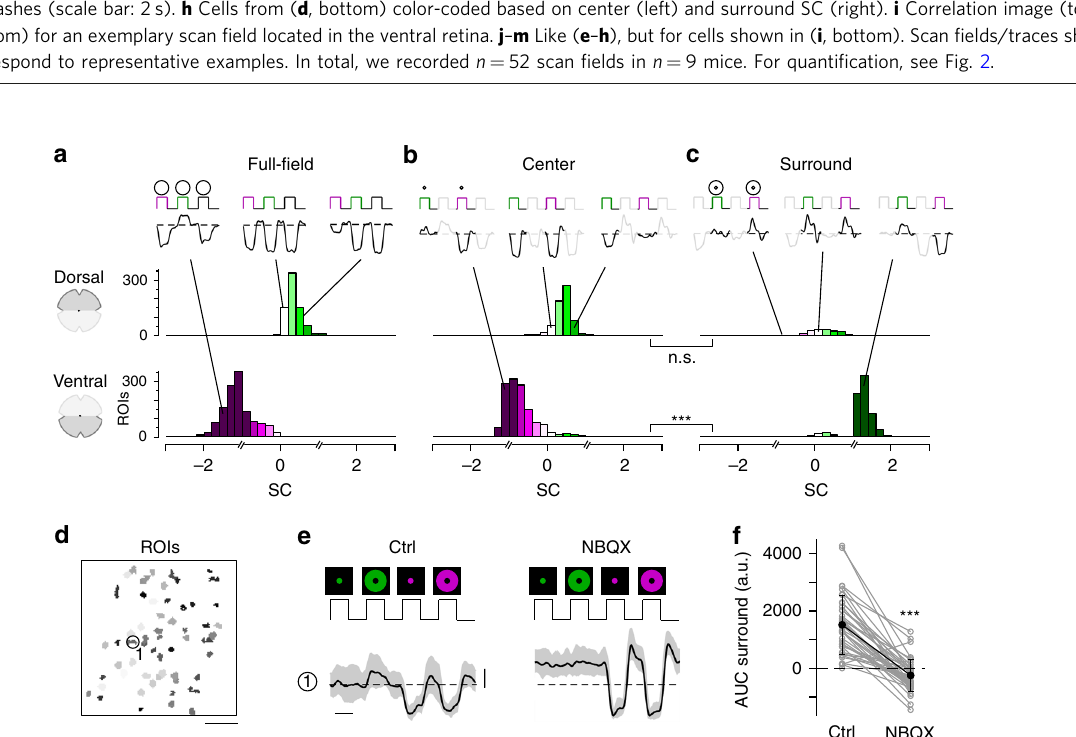
Fig. 2 Differential chromatic processing in ventral and dorsal cones. a – c Histograms of spectral contrast (SC) of dorsal (top) and ventral (bottom) cones in response to full- fi eld ( a , n = 791/1329 dorsal/ventral ROIs), center ( b , n = 671/1337 dorsal/ventral ROIs), and surround ( c , n = 216/841 dorsal/ventral ROIs) fl ashes. Mean glutamate traces of single cones above histograms illustrate the diversity of cone responses to chromatic stimuli. Interestingly, only a fraction of cones showed antagonistic surround responses characterized by an increase in glutamate release (dorsal retina: n = 689/922 cones; ventral retina: n = 1344/2181 cones, n = 52 scan fi elds, n = 9 mice; Supplementary Discussion). Breaks in the x -axis indicate where different equations for estimating SC were used (Methods). n.s. not signi fi cant ( p = 0.053); *** p = 2.2 × 10 − 16 ; linear mixed-effects model for partially paired data (for details, see Methods and Supplementary Methods). d ROI mask of scan fi eld located in ventral retina. Scale bar: 20 µ m. e Glutamate traces of exemplary cone from d in response to UV and green center and surround fl ashes under control and drug condition (50 µ M NBQX). Traces show mean glutamate release with s. d. shading ( n > 10 trials; error bar: 1 s.d.). Traces scaled according to s.d. of baseline. Scale bar: 1 s. f Effect of bath-applied NBQX on area under the curve (AUC) of green-sensitive surround responses of ventral cones ( n = 40 ROIs, n = 3 scan fi elds, n = 2 mice). Error bars show ±s.d. *** p < 0.001; Wilcoxon signed-rank test for paired